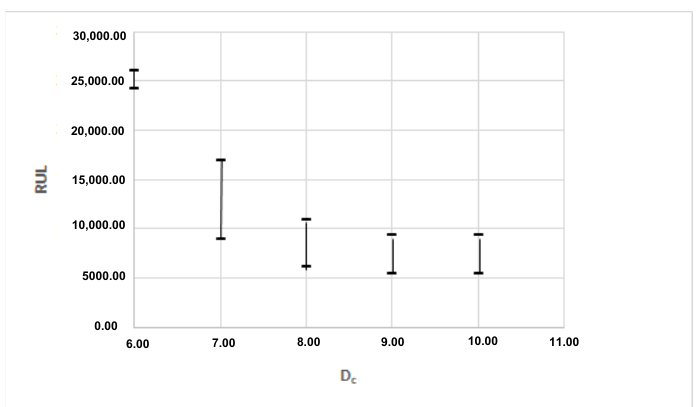
Figure 26. Variations of [ RUL lim